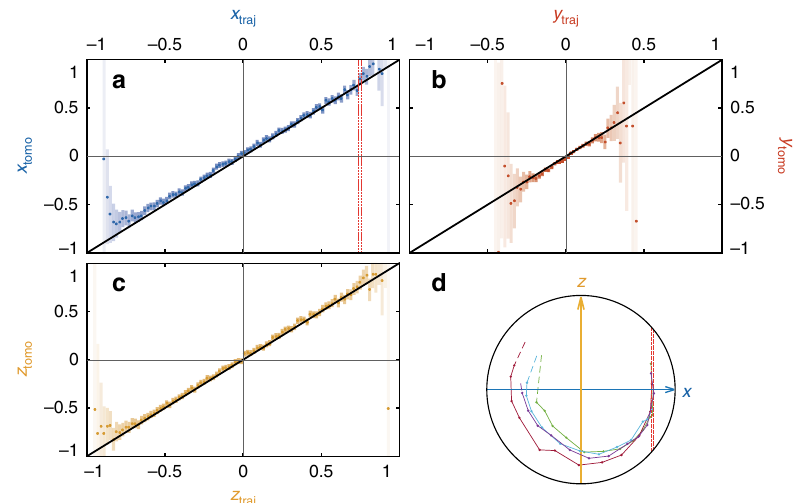
Fig. 3 Tomographic validation of the quantum trajectories. a – c Correlations between the coordinates ( x traj , y traj , z traj ) of the trajectories after 19.8 μ s of evolution and an independent tomography on the dataset corresponding to the experiment of Fig. 2a. Each panel represents the average value of the tomography results for the subset of trajectories ending up within 0.01 distance from a given value of x traj ( a) , y traj ( b) , or z traj ( c) . The error bars are given by the standard deviation of the tomography results divided by the square root of the number of trajectories in the subset (out of a total number of 1.5 million trajectories per panel). The agreement between the tomography and the coordinates of the trajectories demonstrates the validity of the quantum trajectories. d Bloch sphere representation of three quantum trajectories that end up with 0.74 < x traj < 0.76 (red dashed line) after 19.8 μ s corresponding to one bin of the histogram in